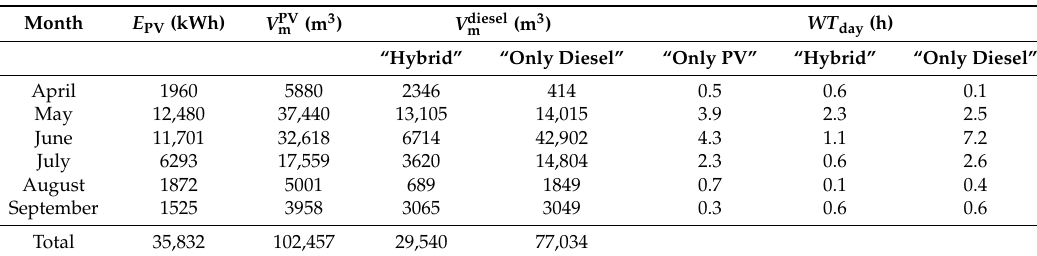
Table 6. Real operational data in 2017.